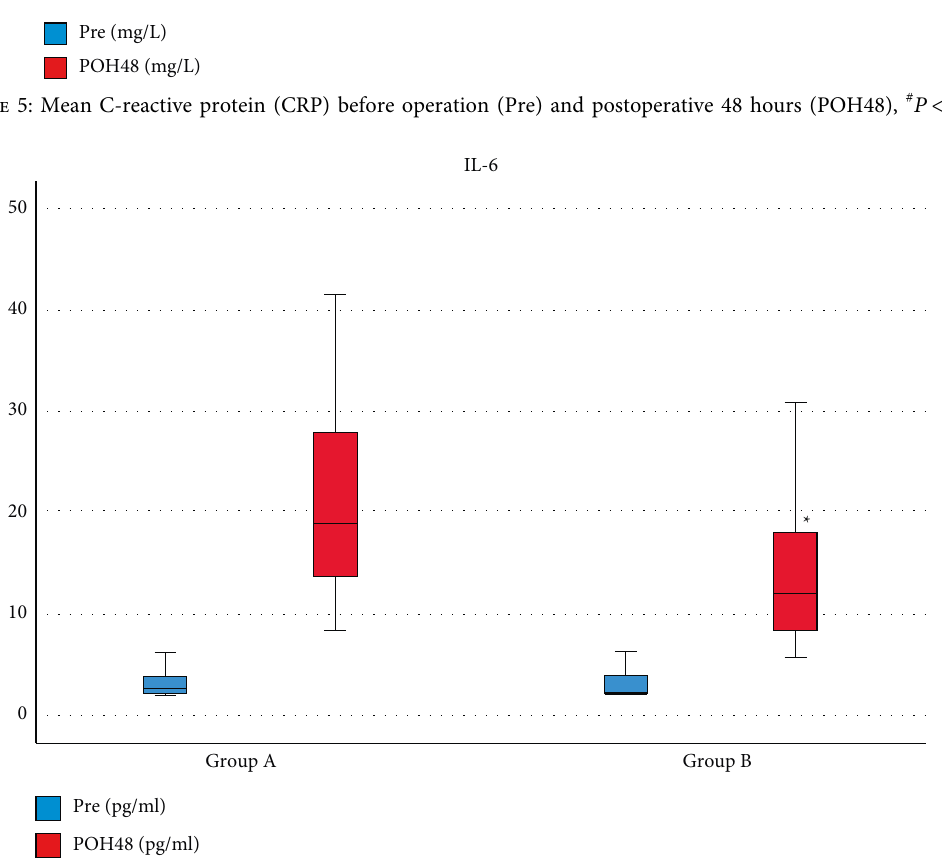
Figure 6: Mean interleukin-6 (IL-6) before operation (Pre) and postoperative 48 hours (POH48), ∗ P < 0 .